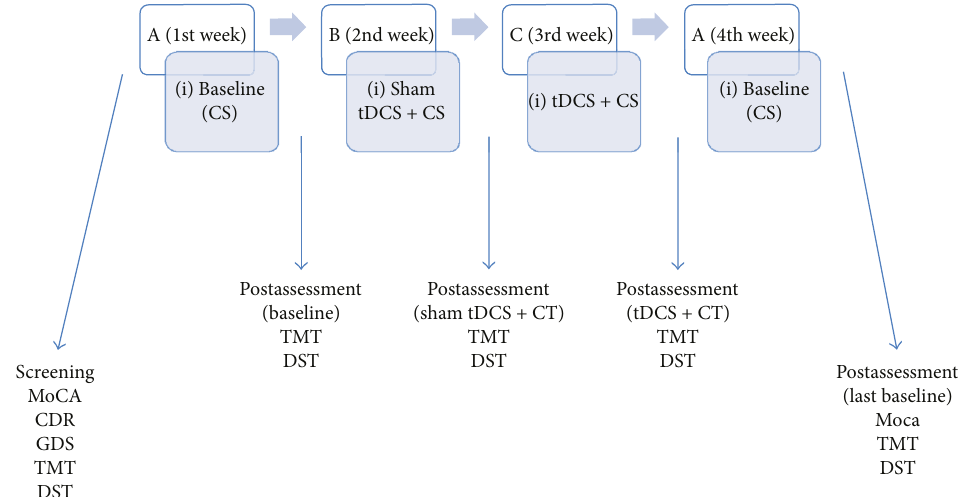
Figure 1: Intervention sequence. A-B-C-A design; MoCA: Montreal Cognitive Assessment; CDR: Clinical Dementia Rating; GDS: Geriatric Depression Scale; TMT: Trail Making Test; DST: digit span test. Phases. CS: cognitive stimulation; tDCS: transcranial direct current